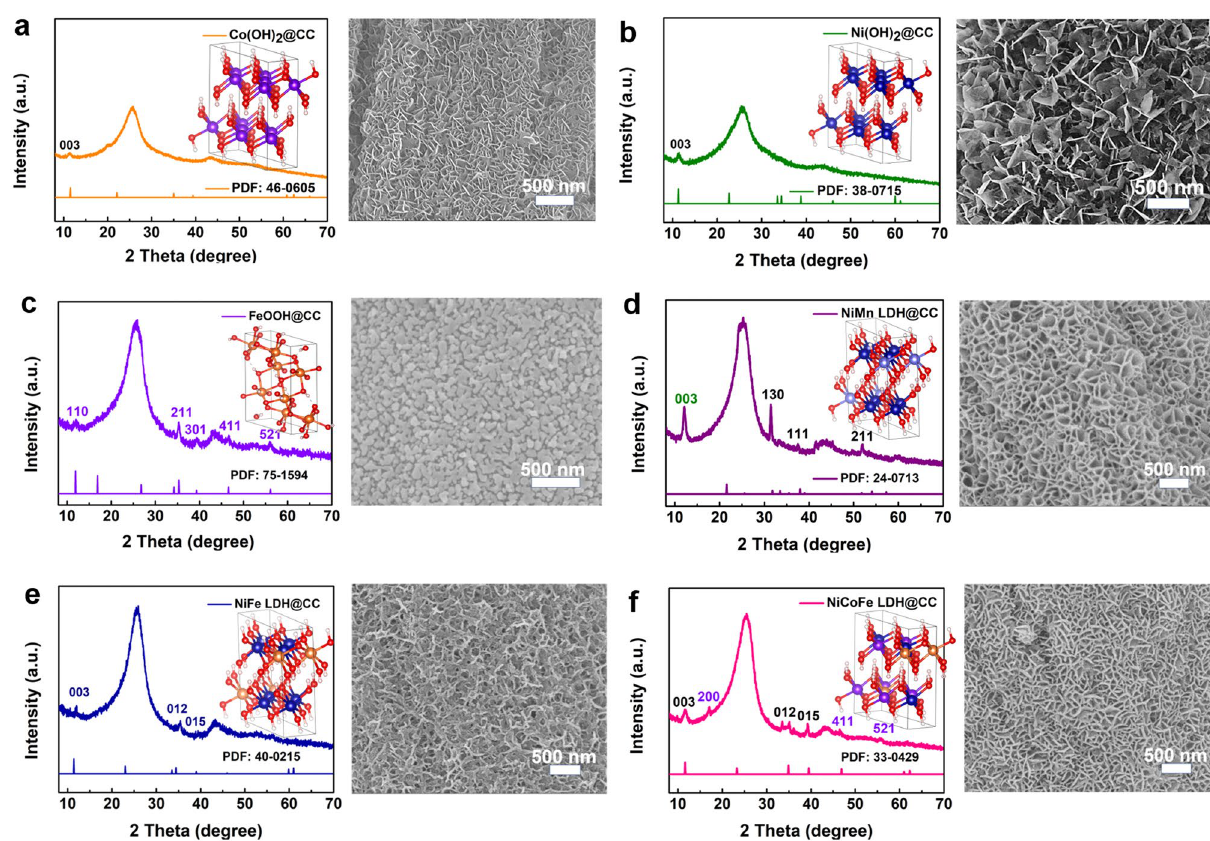
Fig. 4 XRD patterns and SEM images of metal hydroxides based on CC a Co(OH) 2 @CC, b Ni(OH) 2 @CC, c FeOOH@CC, d NiMn LDH@ CC, e NiFe LDH@CC, f